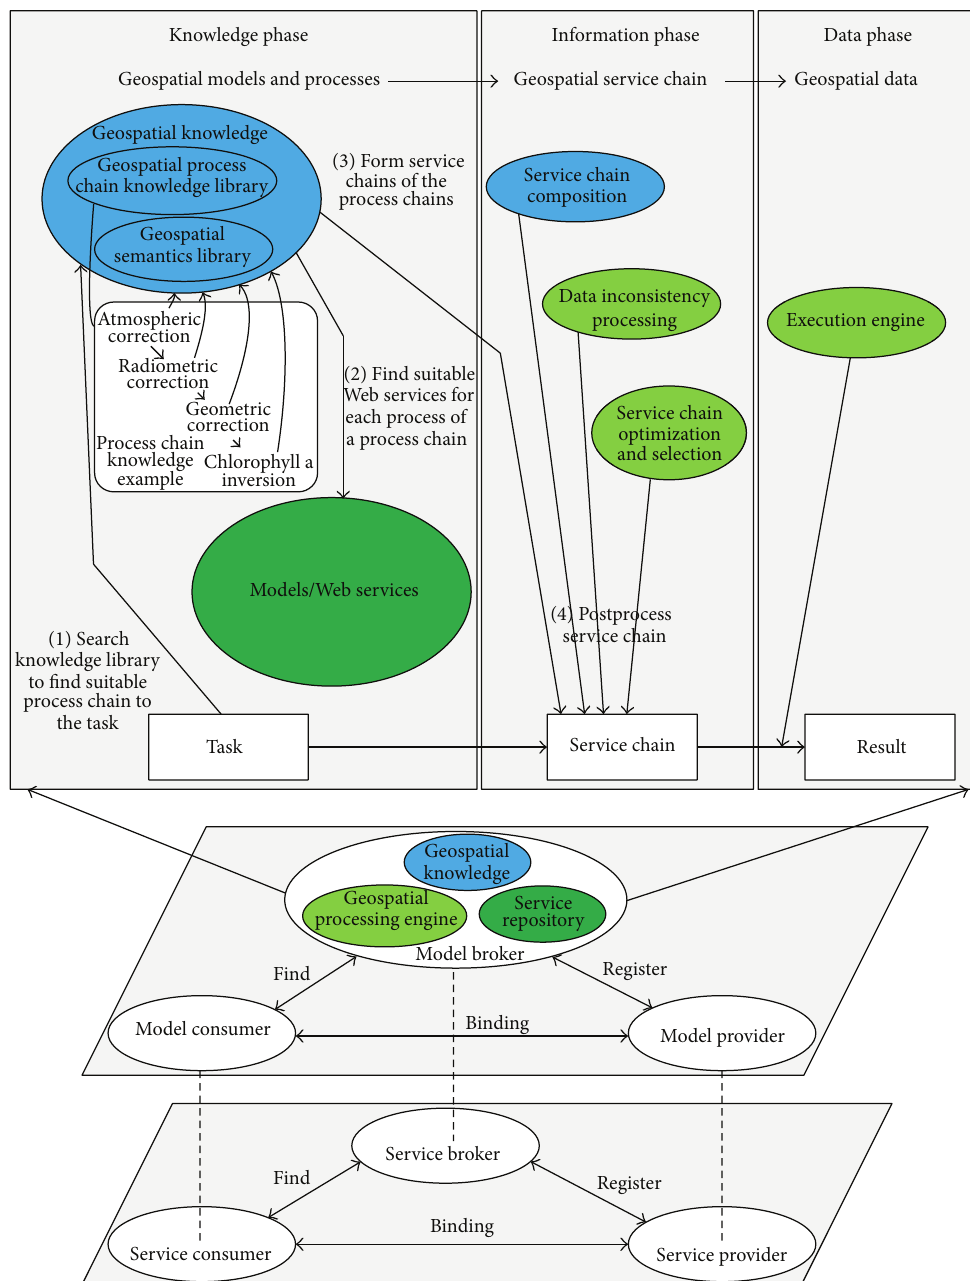
Figure 4: Integrate GIS and RS models based on Web service under the GPW